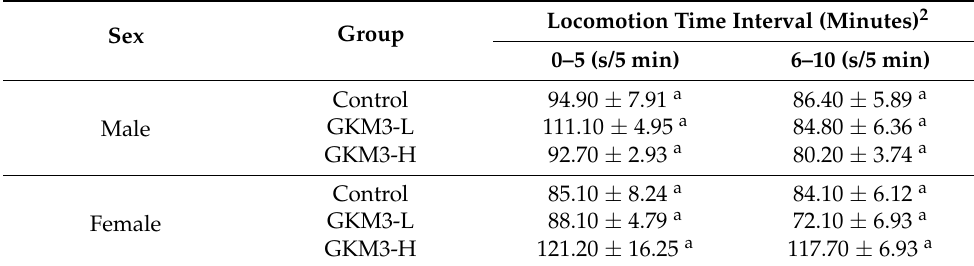
Table 2. The locomotion activity of SAMP8